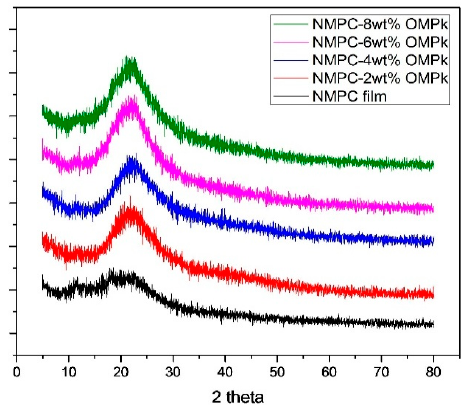
Figure 8. X-ray diffraction (XRD) diffractograms of the N -methylene phosphonic chitosan (NMPC) film, NMPC/2 wt % O -methylene phosphonic κ -carrageenan (OMPk), NMPC/4 wt % OMPk, NMPC/6 wt % OMPk, and NMPC/8 wt % OMPk.